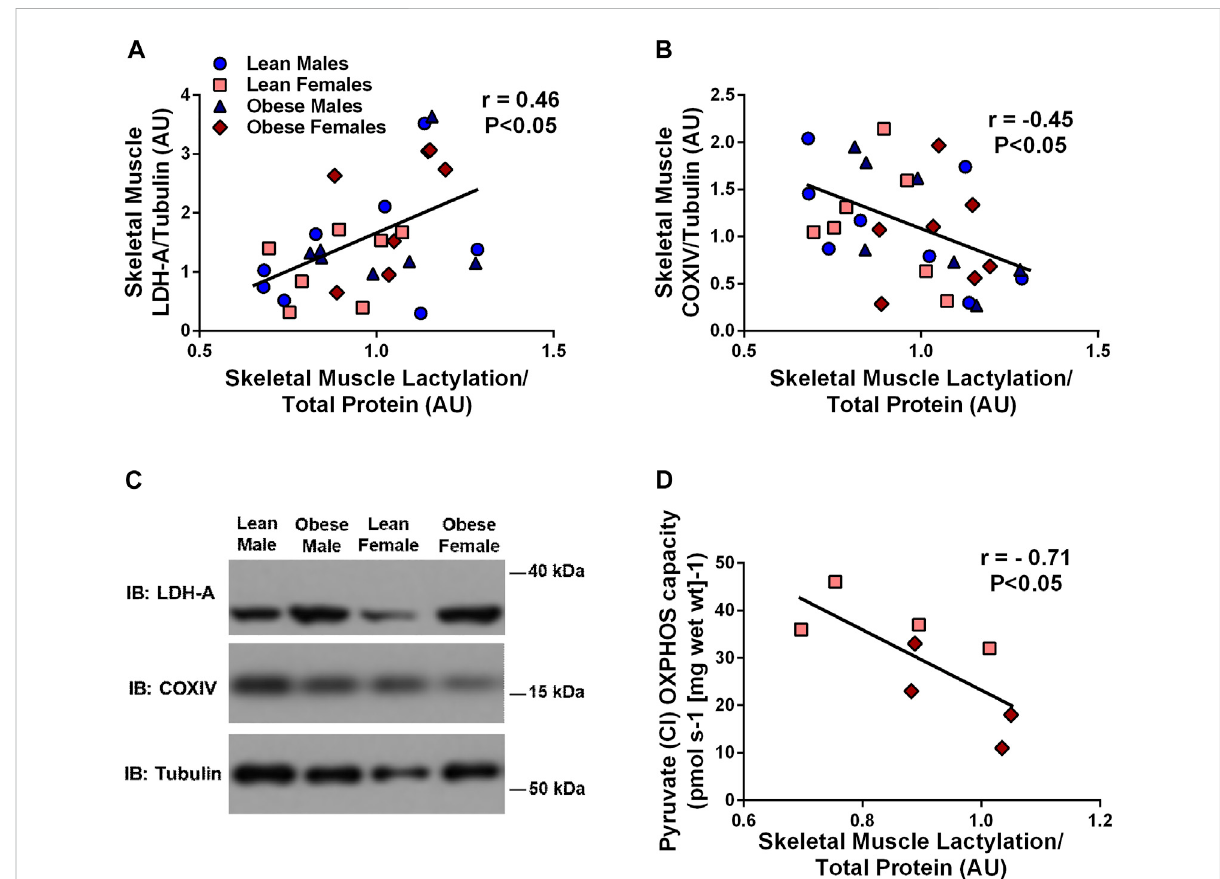
Relationship Between Human Skeletal Muscle Lactylation and Markers of Skeletal Muscle Anaerobic/Oxidative Metabolism. Relationship of skeletal muscle LDH-A protein expression and skeletal muscle lactylation in the whole group (n = 29) (A) . Relationship of skeletal muscle COXIV proteinexpressionandskeletalmusclelactylationinthewholegroup(n=29) (B) .LDH-AandCOXIVwerenormalizedtotubulinandlactylationlevels were normalized to Coomassie Blue. Representative blots for skeletal muscle COXIV and LDH-A in lean and obese males and females (C) . Relationship between skeletal muscle complex I (pyruvate supported) OXPHOS capacity in permeabilized skeletal muscle fi bers and skeletal muscle lactylation in subset of study individuals (n = 4 lean, n = 4 obese) (D) . All skeletal muscle protein values are presented in arbitrary units (AU). Data is expressed as mean ± SEM. Light blue circles represent data points for lean males; light pink squares represent data for lean females; dark blue triangles represent data points for obese males; dark pink diamonds represent data from obese